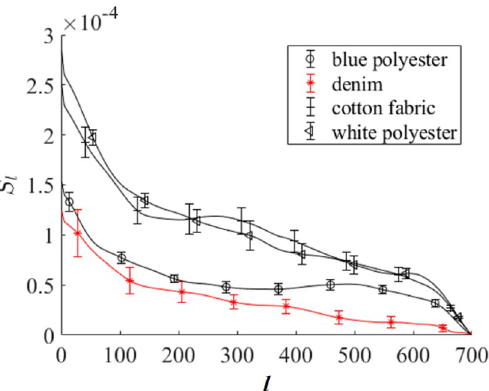
Figure 6. Calculated dependence of the Soergel distance S l on the number of points l in the sliding spectral window for bloodstain spectra on Al foil and common substrates.